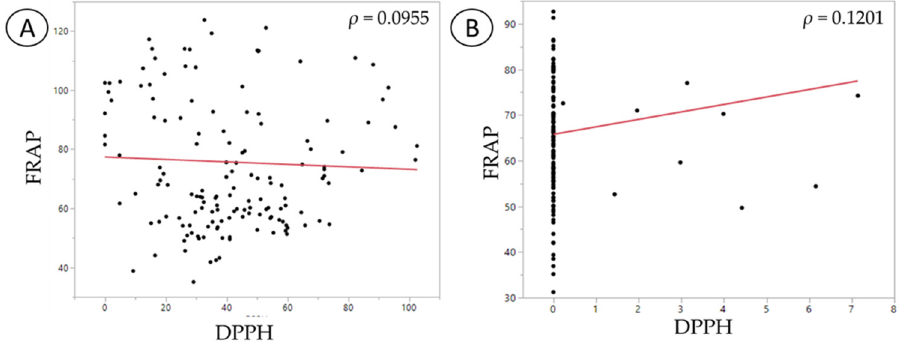
Figure 4. Spearman’s correlation analysis between the antioxidant capacity assays, ferric reducing antioxidant power (FRAP) and 2,2-diphenyl-1-picrylhydrazyl radical (DPPH). ( A ) Normal fecal sample; ( B ) C. difficile -infected fecal sample.